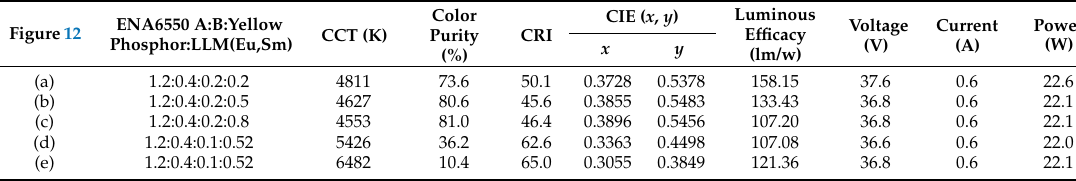
Table 1. The color and electrical parameters of WLEDs coated with phosphor glues of different mass